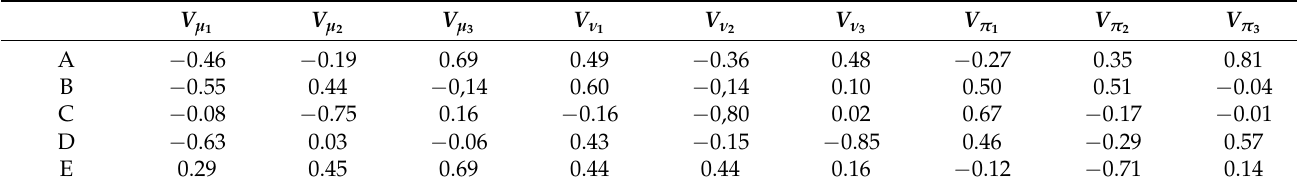
Figure 4. Eigenvalues of the correlation matrix R . Table 6. PCA